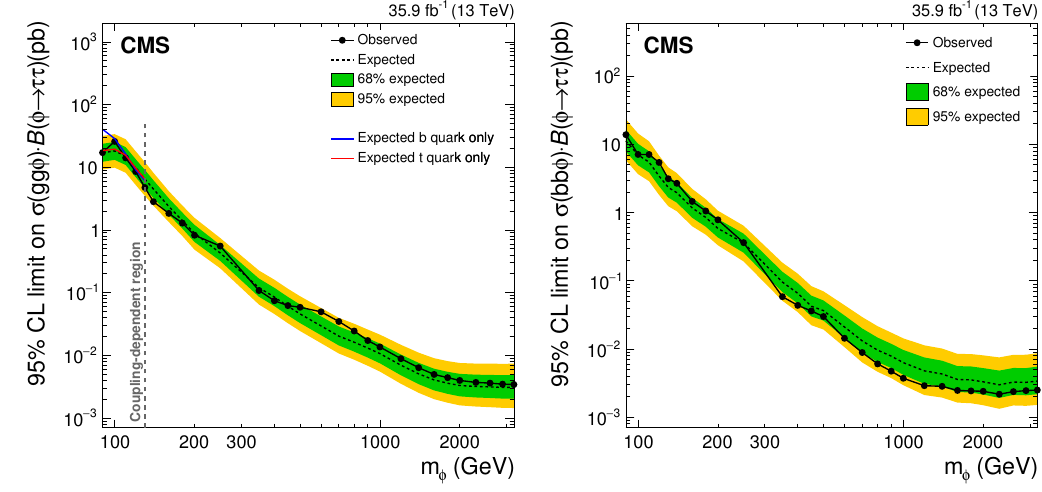
Figure 7 . Expected and observed 95% CL upper limits for the production of a single narrow resonance, (cid:30) , with a mass between 90 GeV and 3.2 TeV in the (cid:28)(cid:28) (cid:12)nal state (left) for the production via gluon fusion (gg (cid:30) ) and (right) in association with b quarks (bb (cid:30) ). The expected median of the exclusion limit is shown by the dashed line. The dark green and bright yellow bands indicate the 68 and 95% con(cid:12)dence intervals for the variation of the expected exclusion limit. The black dots correspond to the observed limits. In the left panel the expected exclusion limits for the cases where (blue continuous line) only the b quark and (red continuous line) only the t quark are taken into account in the fermion loop are also shown. Left of the dashed vertical line the two di(cid:11)erent assumptions lead to visible di(cid:11)erences in the expected exclusion